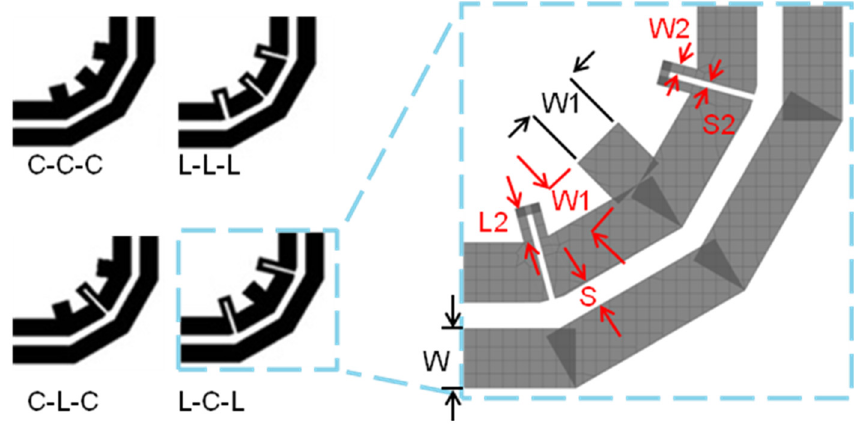
Figure 9. Hybrid compensation types, C-C-C, L-L-L, C-L-C, and L-C-L.